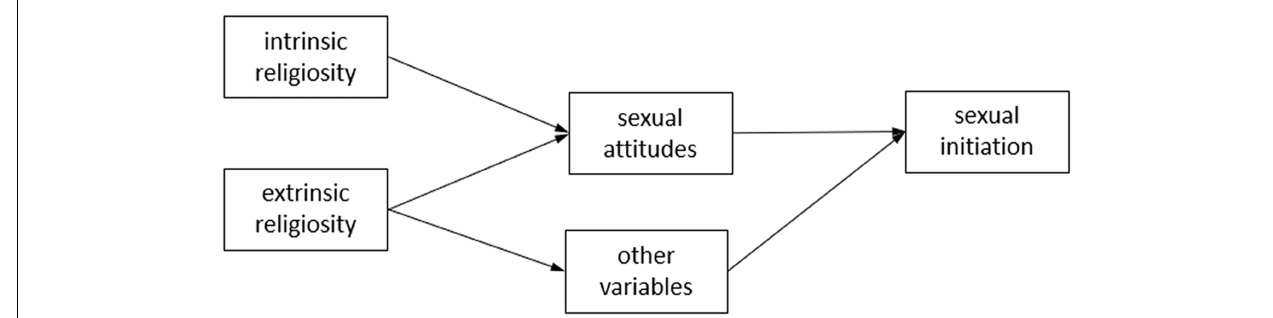
FIGURE 1 | Theoretical model of the relationship between religiosity dimensions and sexual